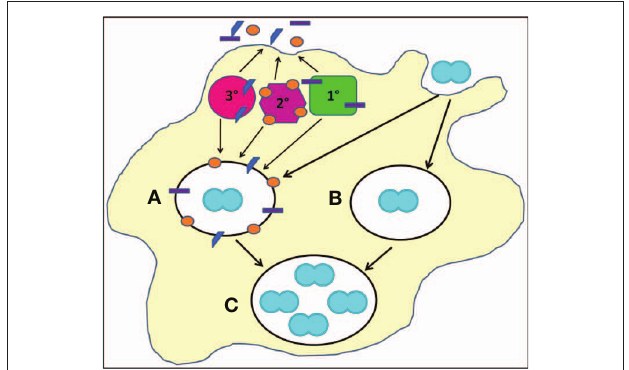
Figure 2 | Cellular mechanisms of gc survival after exposure to PMNs. Gc (blue diplococcus) attaches to the surface of PMNs and is engulfed into a phagosome (white oval). PMNs possess three classes of granules (1 ° , 2 ° , and 3 ° ), each of which contains a unique subset of antimicrobial compounds. Granules fuse with the nascent phagosome or plasma membrane to deliver their contents to invading microorganisms. We propose two mechanisms that allow Gc to survive after exposure to PMNs. (For illustrative purposes, only intracellular Gc survival is depicted.) First, PMN granules release their contents at the plasma membrane or into phagosomes containing Gc (A) . However, Gc virulence factors confer resistance to granules’ antimicrobial compounds. Second, Gc prevents PMN granules from releasing their contents at the plasma membrane or into phagosomes, allowing the bacteria to avoid encountering PMN antimicrobial compounds (B) . Either mechanism would enable a fraction of Gc to survive and replicate in the presence of PMNs